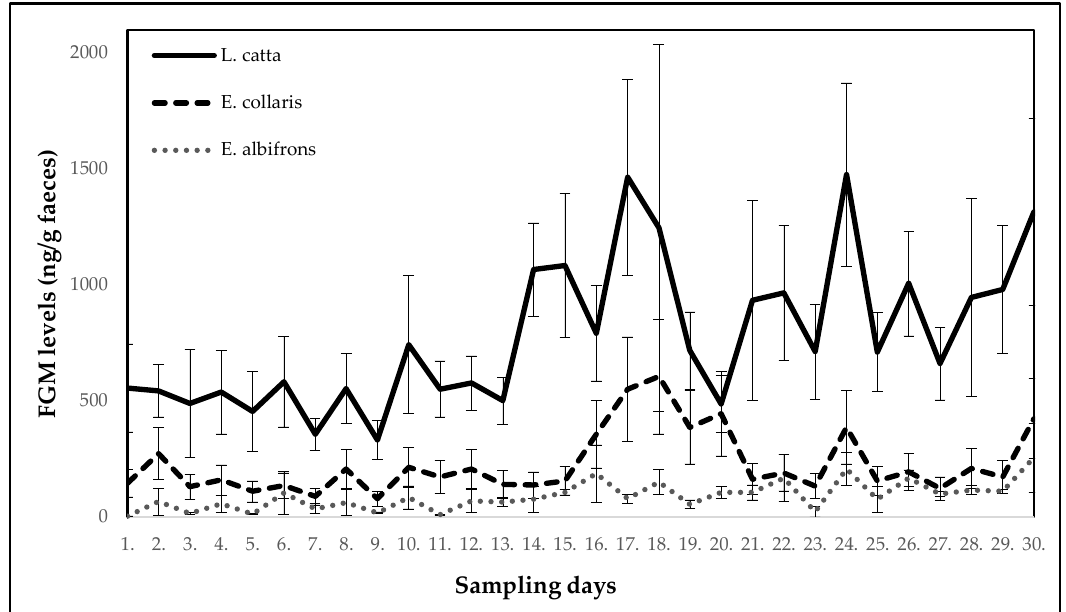
Figure 5. Comparison of glucocorticoid levels in three lemur species.